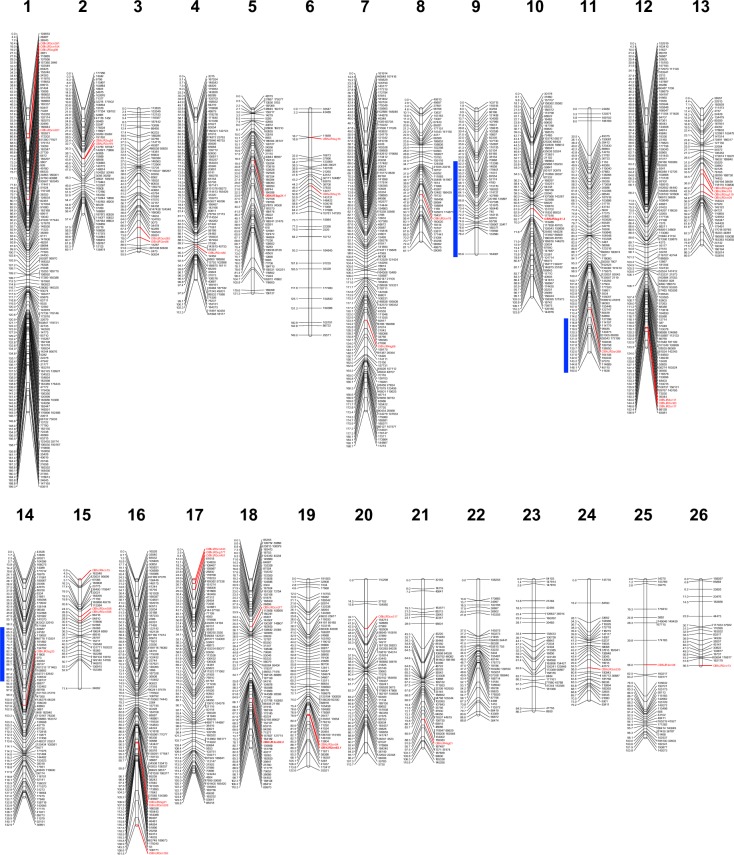
Sweet basil linkage map constructed for MRI x SB22 F2 intercross family.The map includes 1,847 SNP (black font) and 42 EST-SSR markers (red font) across 26 LGs for a total length of 3030.9 cM. Two pairs of multi-locus EST-SSR (bold/italic/red font) markers represent putative homeologous pairs of loci (LGs 5,10 and 18,19). Blue lines represent 1.5 LOD score confidence intervals located to the left of linkage group locations associated with downy mildew resistance.